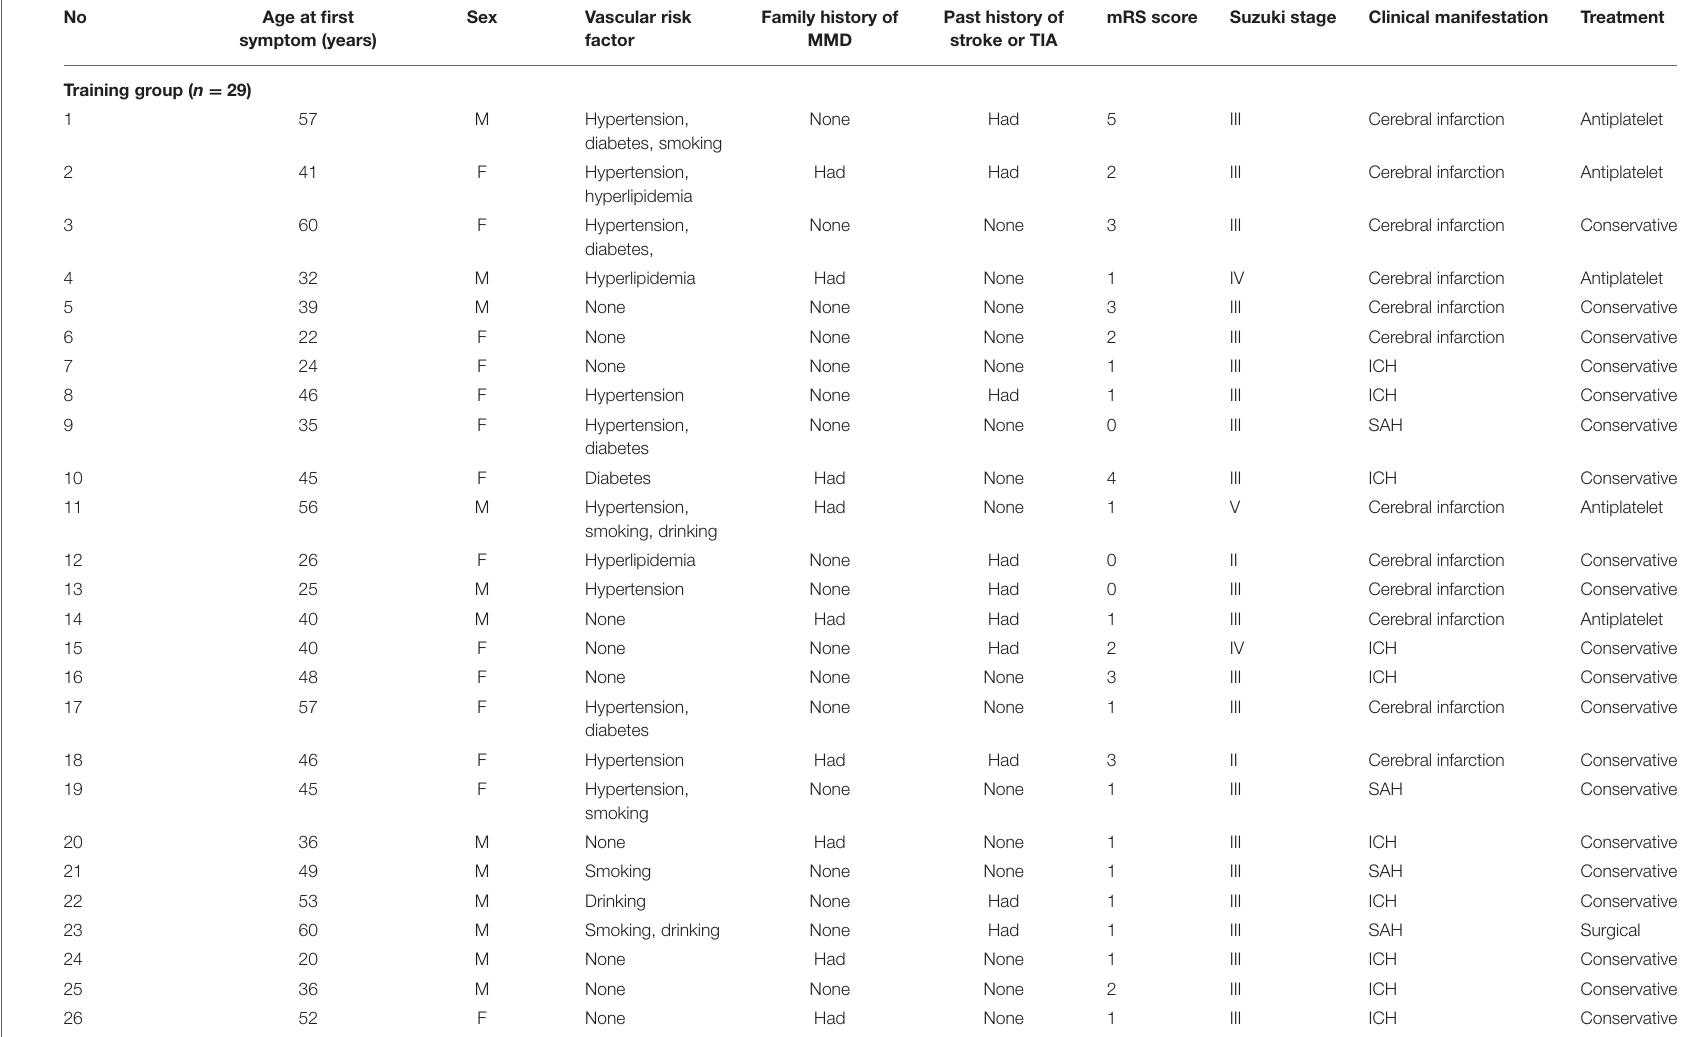
TABLE 2 | Summary of 46 patients with recurrent